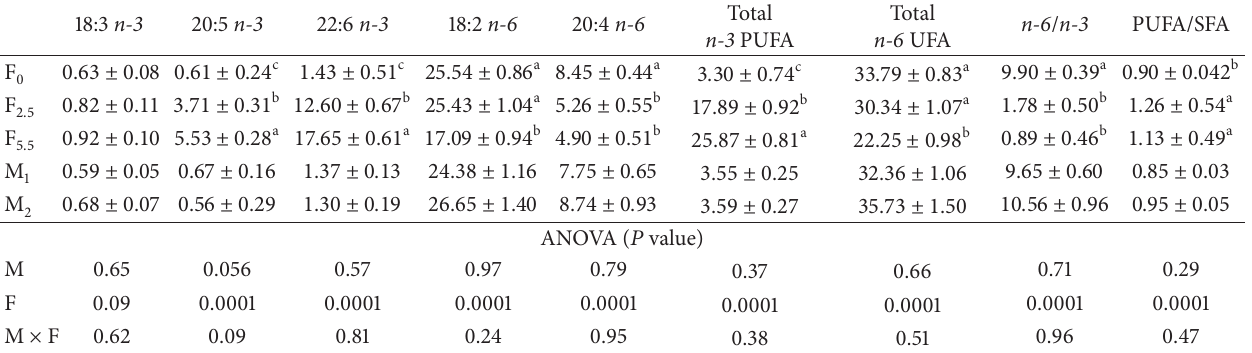
Table 3: Effect of fish oil and methionine supplementation on plasma fatty acids composition of 42-day-old broiler chickens